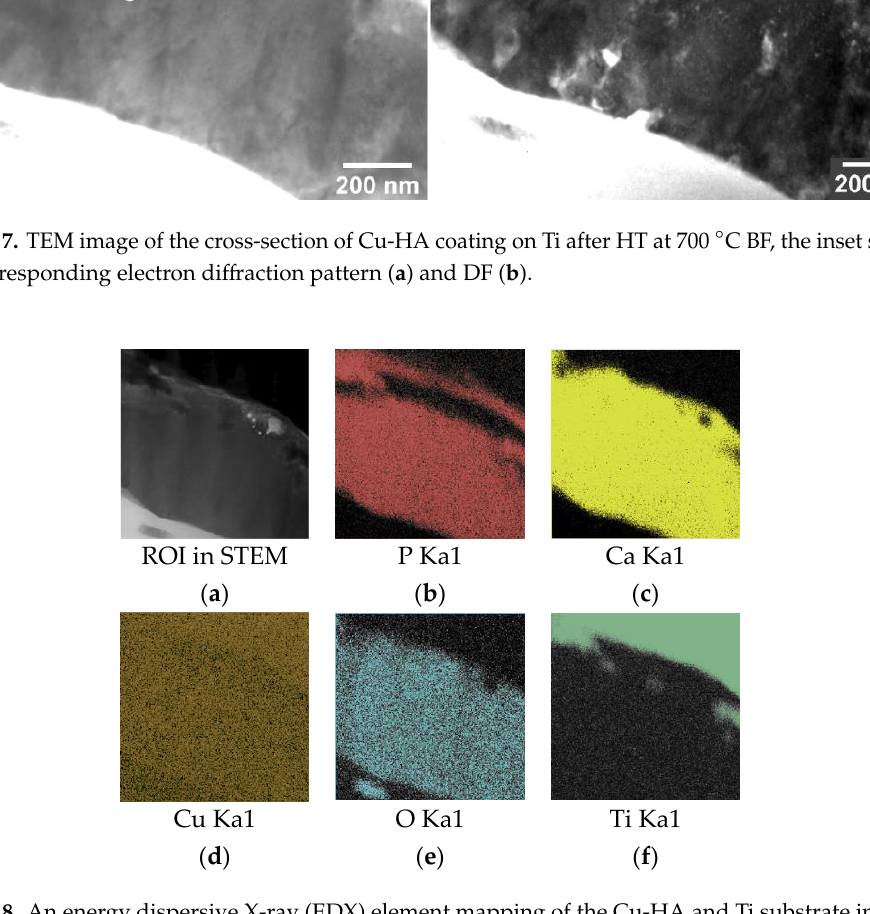
Figure 7. TEM image of the cross-section of Cu-HA coating on Ti after HT at 700 °C BF, the inset shows the corresponding electron diffraction pattern ( a ) and DF ( b ).